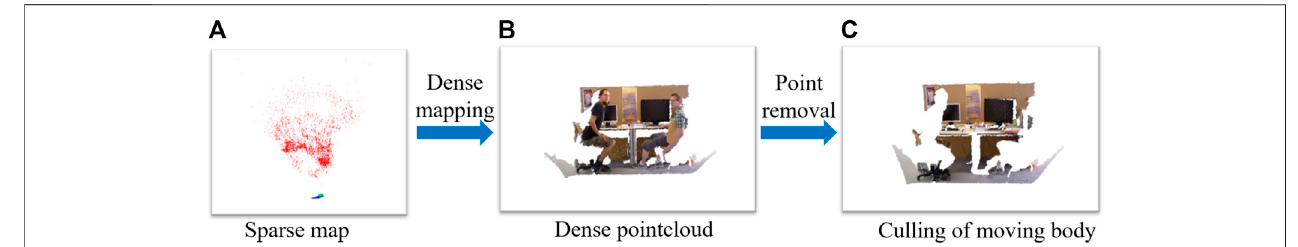
FIGURE 11 | The illustration of presented algorithm for dense point cloud map construction performance in the normal dataset, (A) is the sparse map, (B) is the dense point cloud map construction result, (C) is the dense map with moving body rejected.